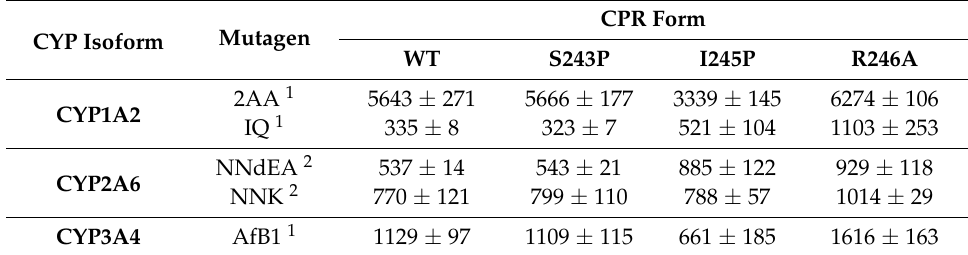
Table 2. CYP-mediated bioactivation of pre-carcinogens.